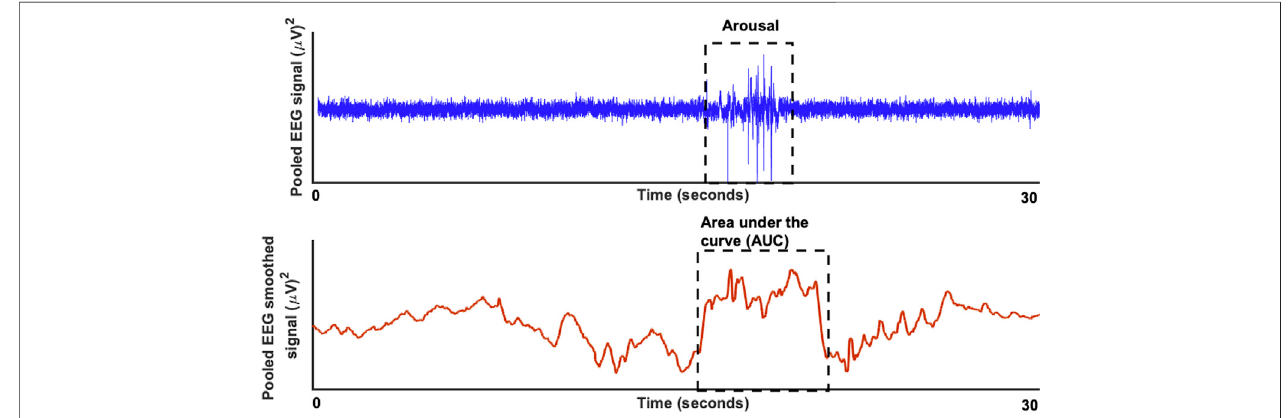
FIGURE 2 | Pipeline fi gure to show the procedure from the raw EEG data, estimating the area under the curve (AUC) and then followed by the linear as well as the SVM regression.